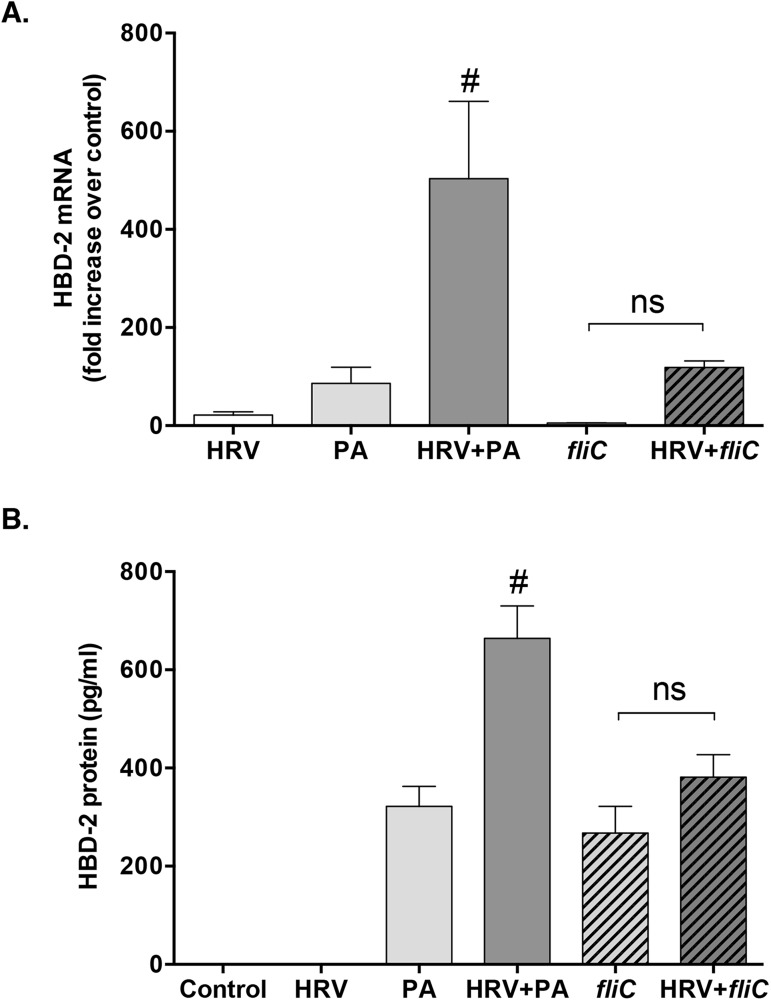
The synergistic response of human beta defensin (HBD)-2 is lost after co-infection with flagellin deficient Pseudomonas aeruginosa (fliC) and human rhinovirus (HRV).HBD-2 mRNA (n = 5) and HBD-2 protein (n = 10) levels were determined following infection of HBE cells for 48 h with HRV-16, wild-type P. aeruginosa (PA), flagellin-deficient P. aeruginosa (fliC) or the combination of either bacterial strain with HRV. Data are expressed as mean ± SEM. Hashtag indicates significant difference compared to all other treatment groups (p<0.05). (ns = not significant).